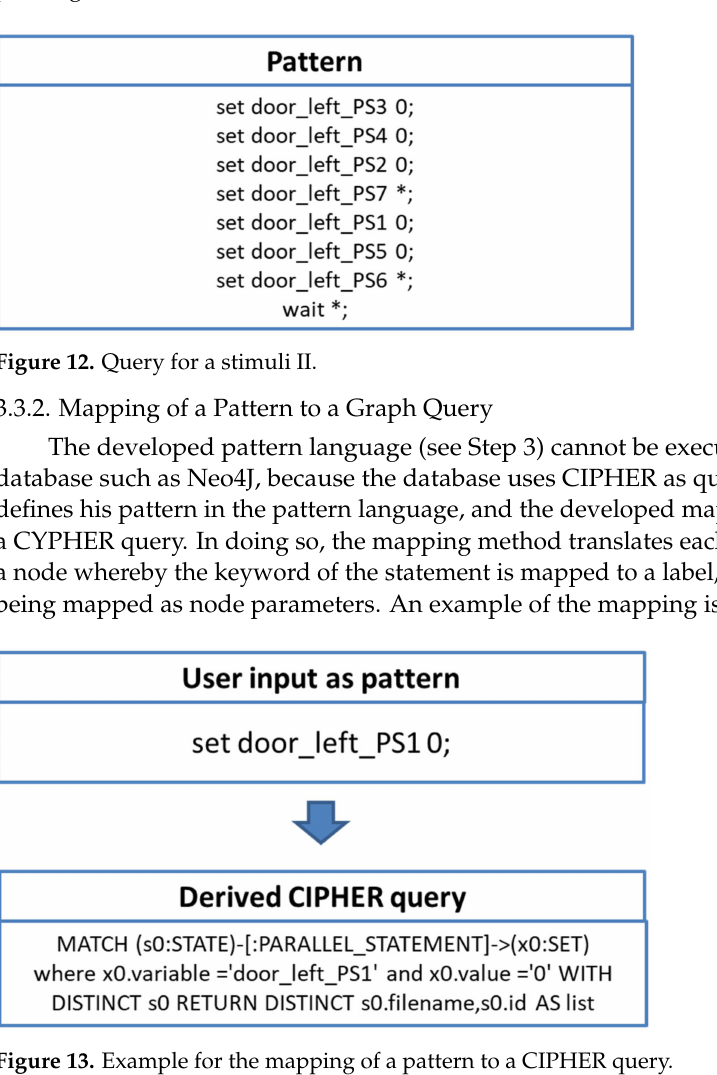
Figure 13. Example for the mapping of a pattern to a CIPHER